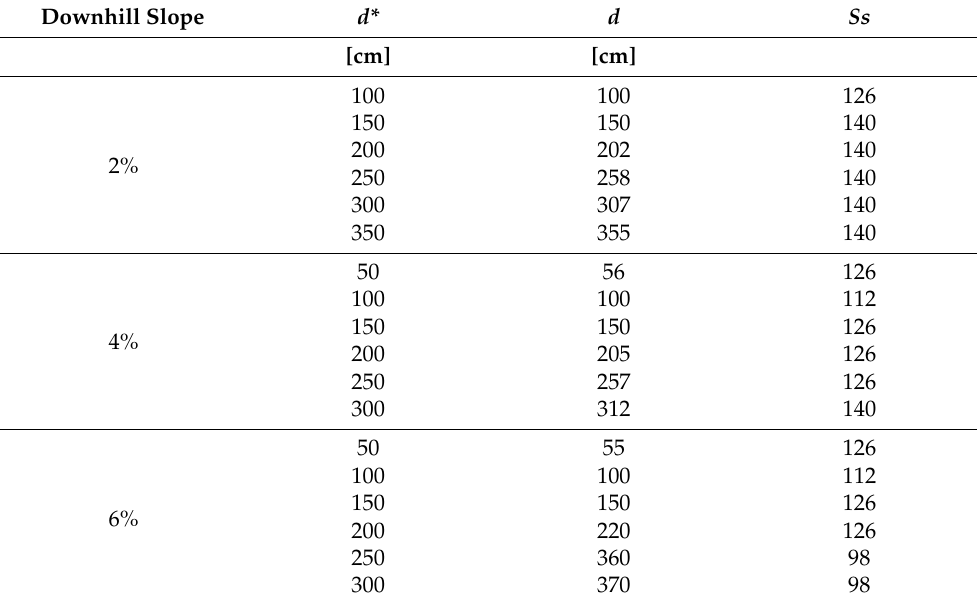
Table 7. Downhill vertical track experimental results with tramcar target on track.